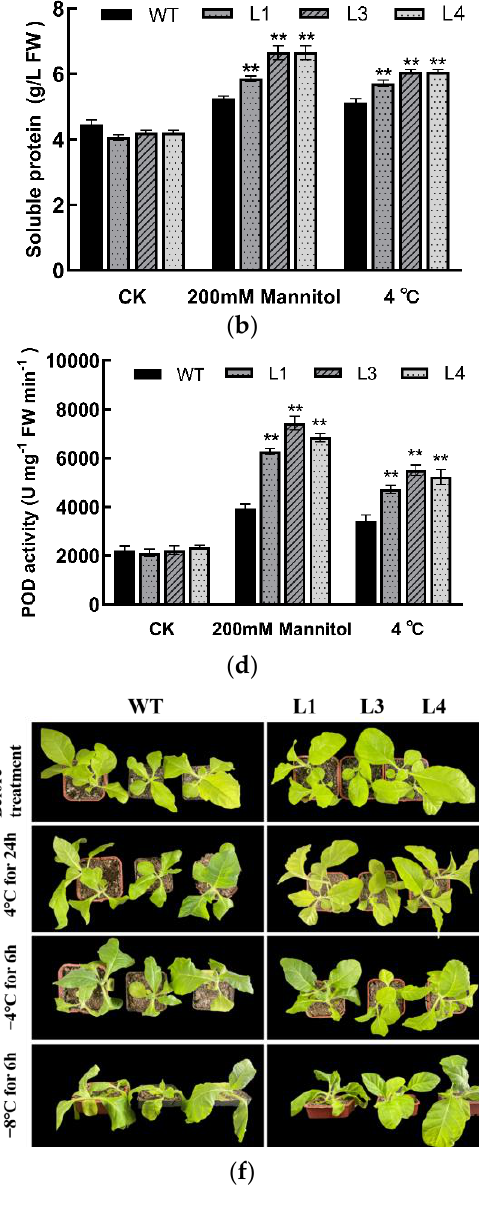
Figure 4. Overexpression of the LoSWEET14 gene increased sugar content and improved the resistance to drought and cold stress of Nicotiana tabacum . Sugar content of transgenic and WT plants ( a ). Analysis of soluble protein ( b ), soluble sugar ( c ), and POD activity ( d ) in WT and transgenic lines untreated (CK), treated with 200mM mannitol, 4 °C, respectively. Morphological changes of WT and transgenic tobacco under drought ( e ) and low temperature ( f ) stress. Each value indicates Mean ± SE (standard error). Asterisks indicate a significant difference ** p < 0.01 compared with the corresponding controls.